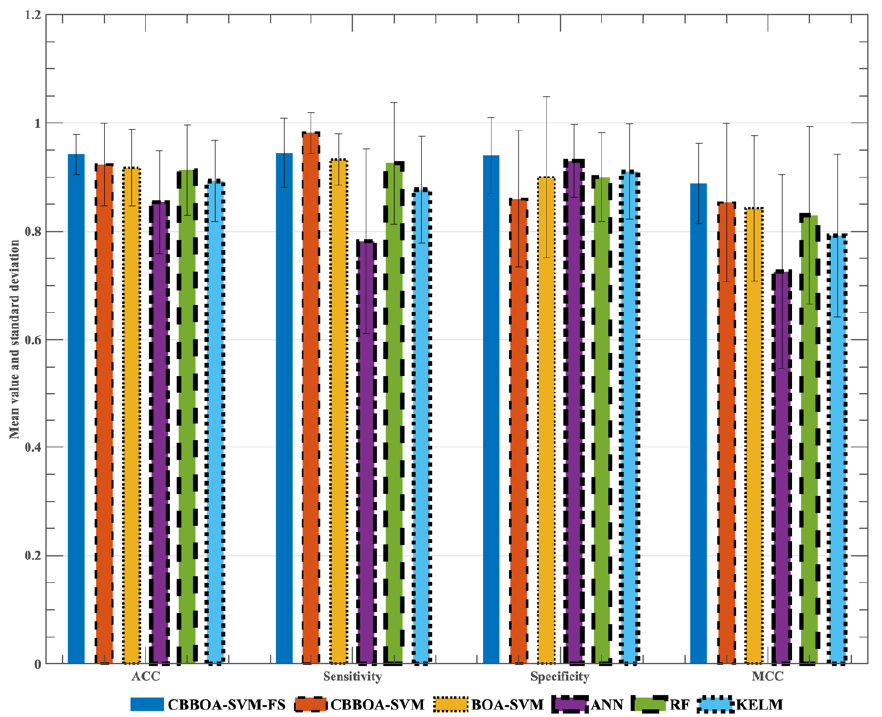
Figure 8. Classification results of five models in terms of four metrics.